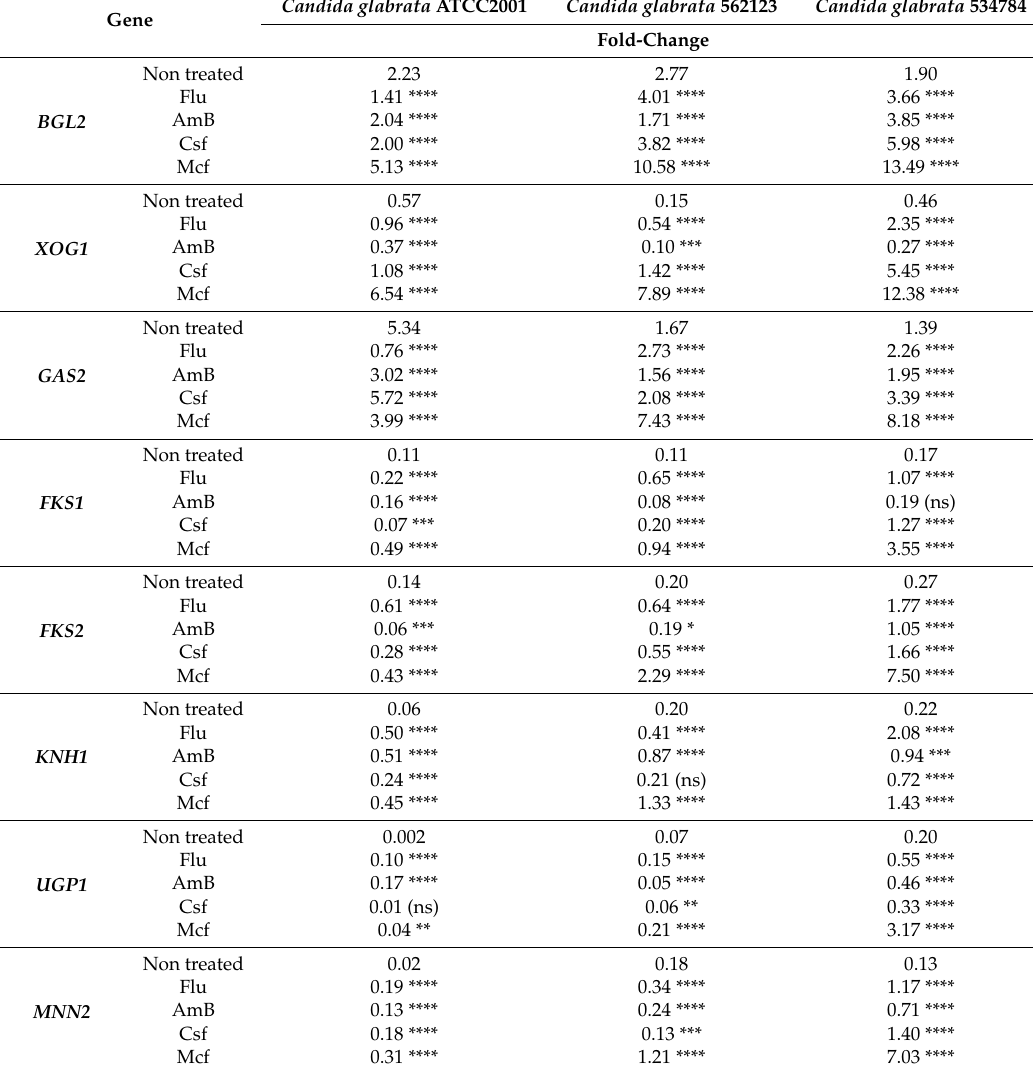
Table 3. Real-time PCR expression profiling of BGL2 , FKS1 , FKS2 , GAS2 , KNH1 , UGP1 , XOG1 , and MNN2 genes in biofilm cells of C. glabrata ATCC2001, C. glabrata 562123, C. glabrata 534784 with and without antifungal treatment (FC: 2 − ∆ C T ). The significance of the FC results was determined by comparing the treated groups with the non-treated ones (controls) (* p < 0.05; ** p < 0.001; *** p < 0.0005; **** p <